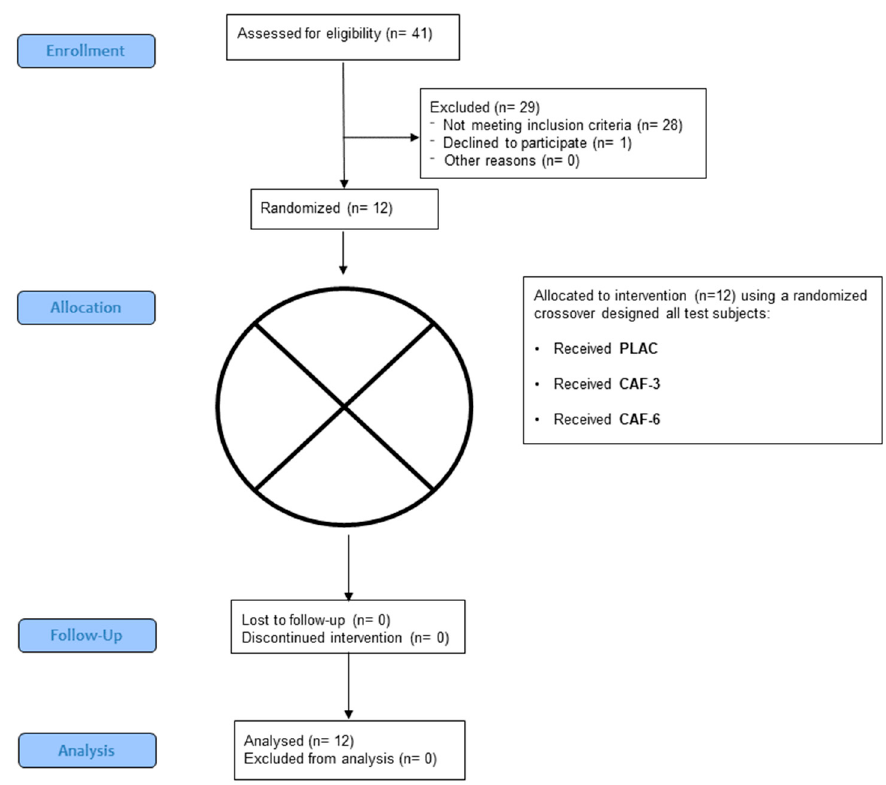
Figure 1. CONSORT flow diagram. n—number of participants; PLAC—placebo; CAF-3—ca ff eine 3mg / kg / b.m; CAF-6—ca ff eine 6mg / kg / b.m.